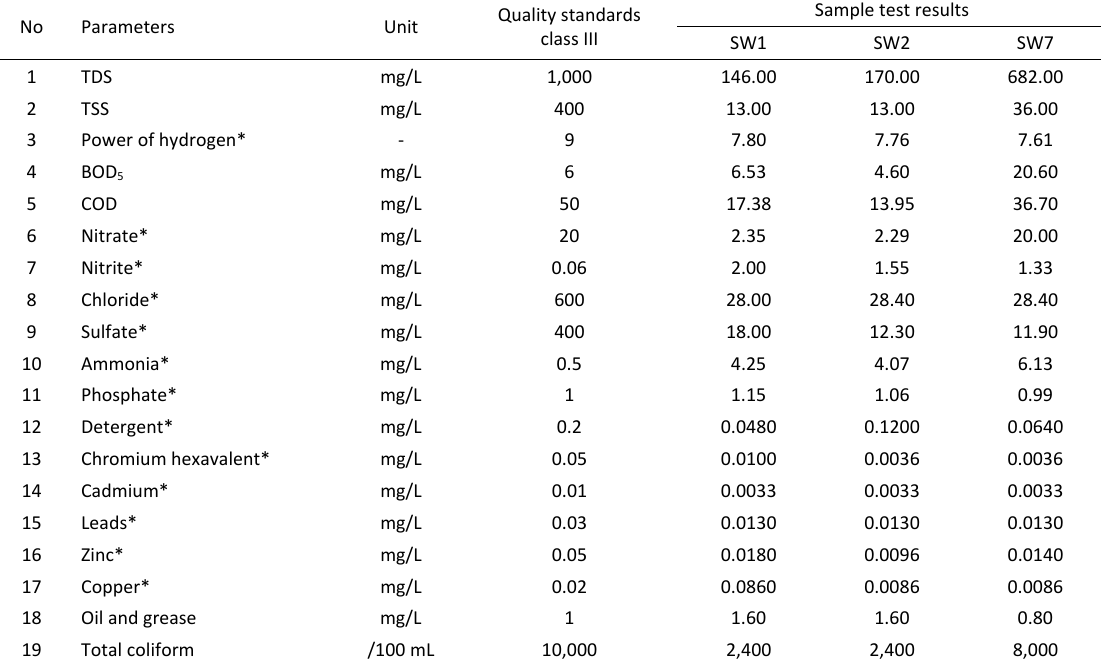
Table 5: Test results of three selected sampling points with additional 13 chemical